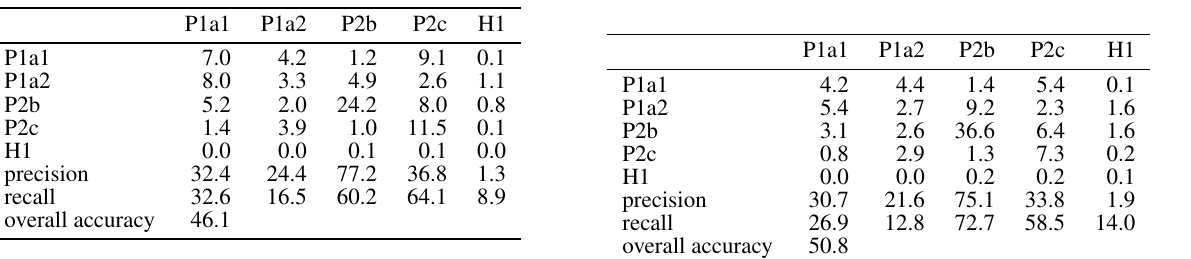
Figure 3. Cross-Validation results for all the classes, with the XGBoost classifier on OBIA objects. Objects: random sampling and cross-validation based on objects. SSAC: stratified-area sampling with area-weighted cross-validation results. SS: stratified-area sampling.